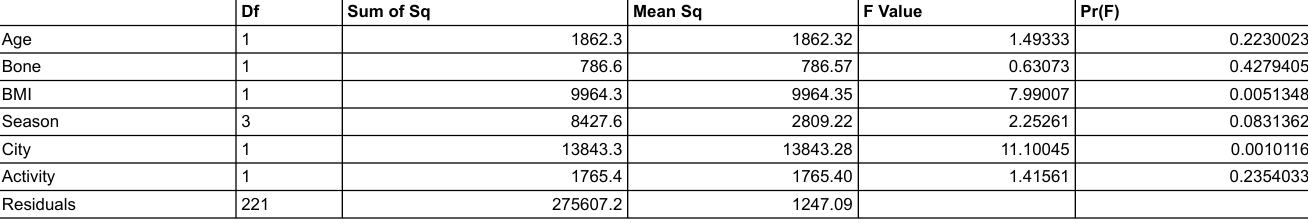
Table S1: Outcome serum 25-hydroxyvitamin D (nmol/l) at first visit: all predictors (type III sum of squares). Df